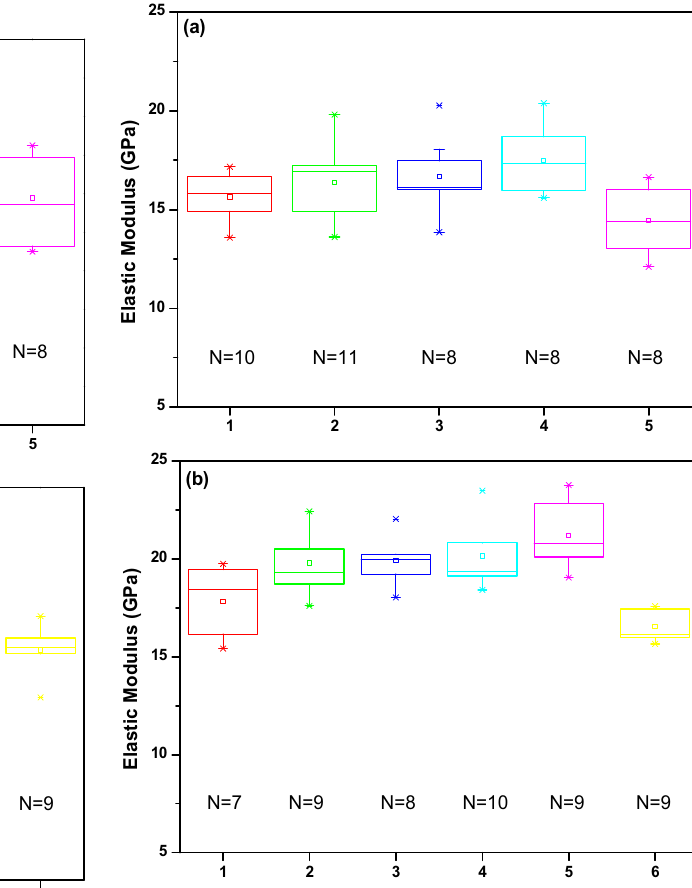
Figure 10: Comparison of the reduced elastic modulus in di ff erent test regions of untreated ( a ) and MAPE and Si69 treated ( b )